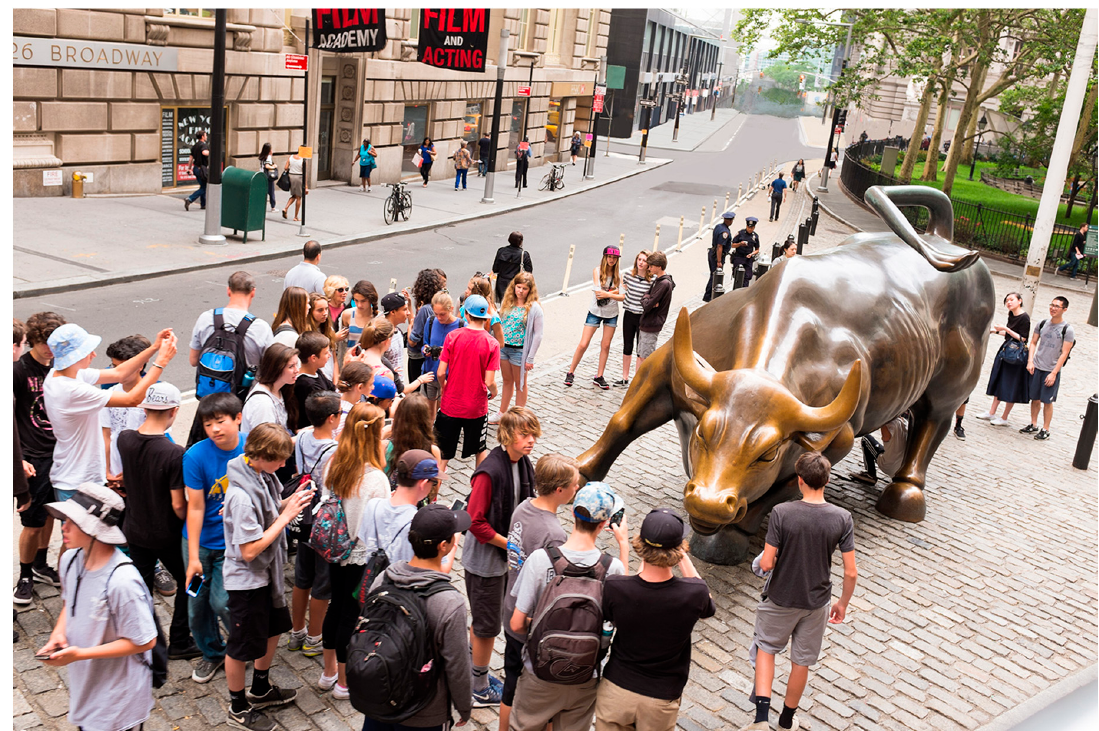
Figure 2. Climate Central’s image of New York City at 2 °C of warming.